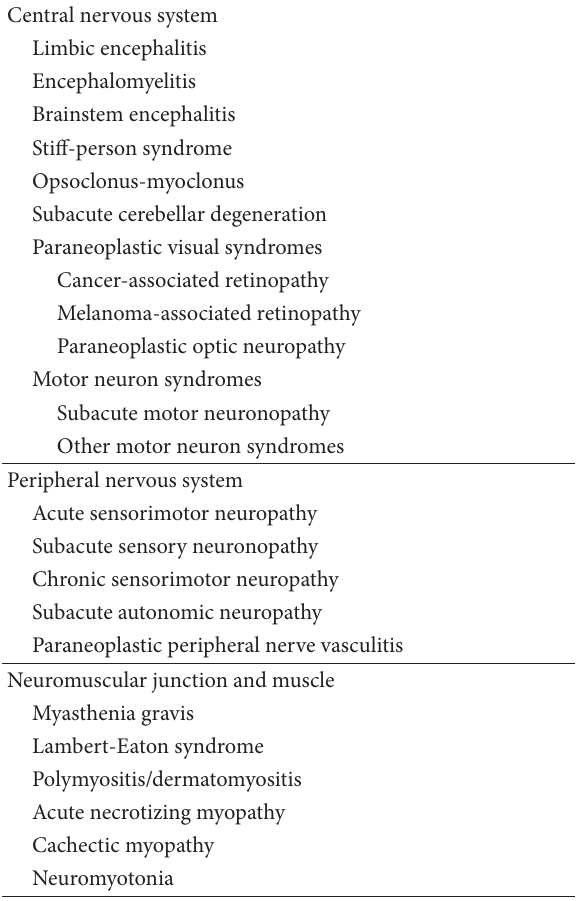
Table 1: Classification of paraneoplastic neurological